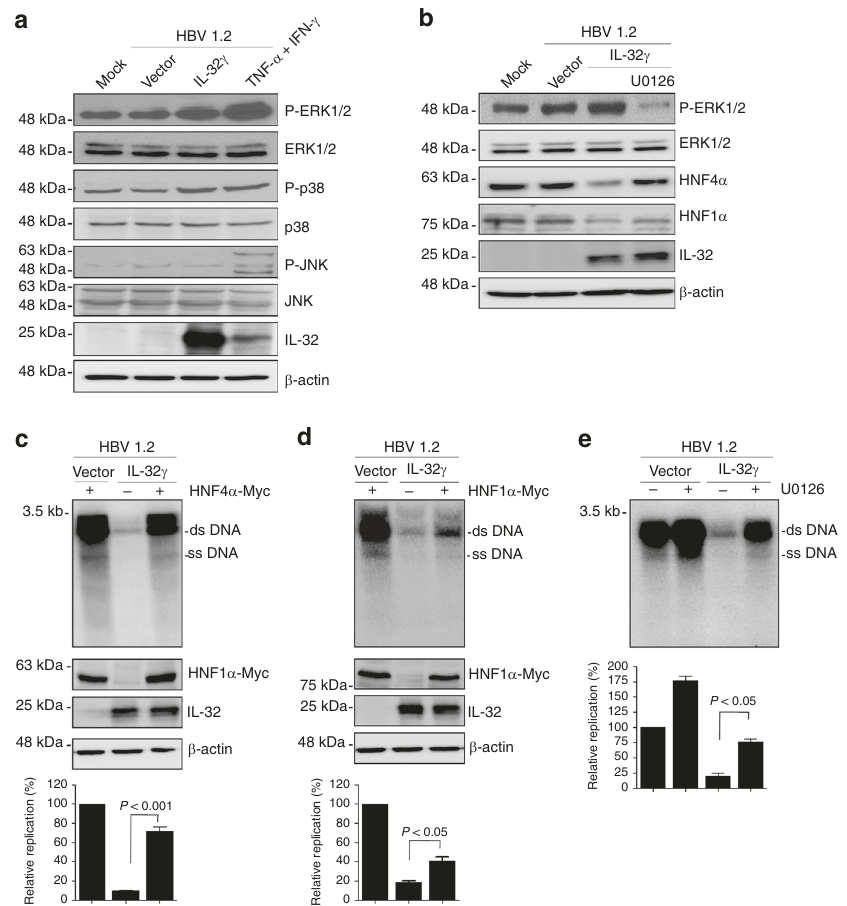
Fig. 5 Involvement of ERK1/2 signaling in IL-32 γ -mediated inhibition of HBV replication. a Effect of IL-32 γ and cytokines on MAPK signaling in Huh7 cells. TNF- α and IFN- γ were added for 30 min before harvest. Activation of MAPK signaling pathways was determined by western blotting with the indicated antibodies. b Effect of ERK1/2 activation inhibitor (10 µ M U0126) on the expression of HNFs. c – e Effect of HNF4 α ( c ), HNF1 α ( d ), and U0126 ( e ) on IL-32 γ - mediated inhibition of HBV replication. Viral replication and protein expression were determined by Southern and western blot analyses, respectively. U0126 was added for 48 h at a fi nal concentration of 10 µ M. Data ( c – e ) were obtained from three independent experiments (mean ± S.D.). p < 0.001, p < 0.05 by Student ’ s t